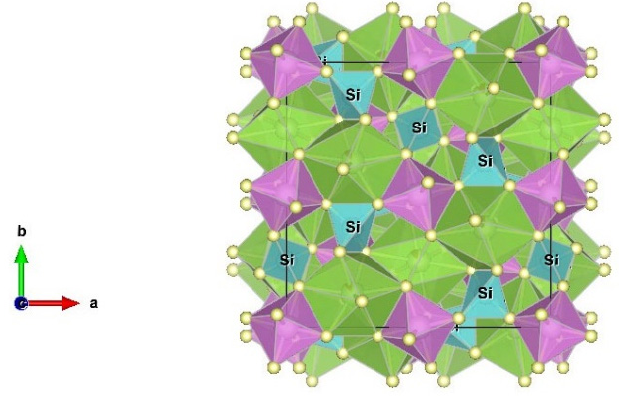
Figure 3. Crystal structure of the garnet (Novak and Gibbs (1971) [2]).